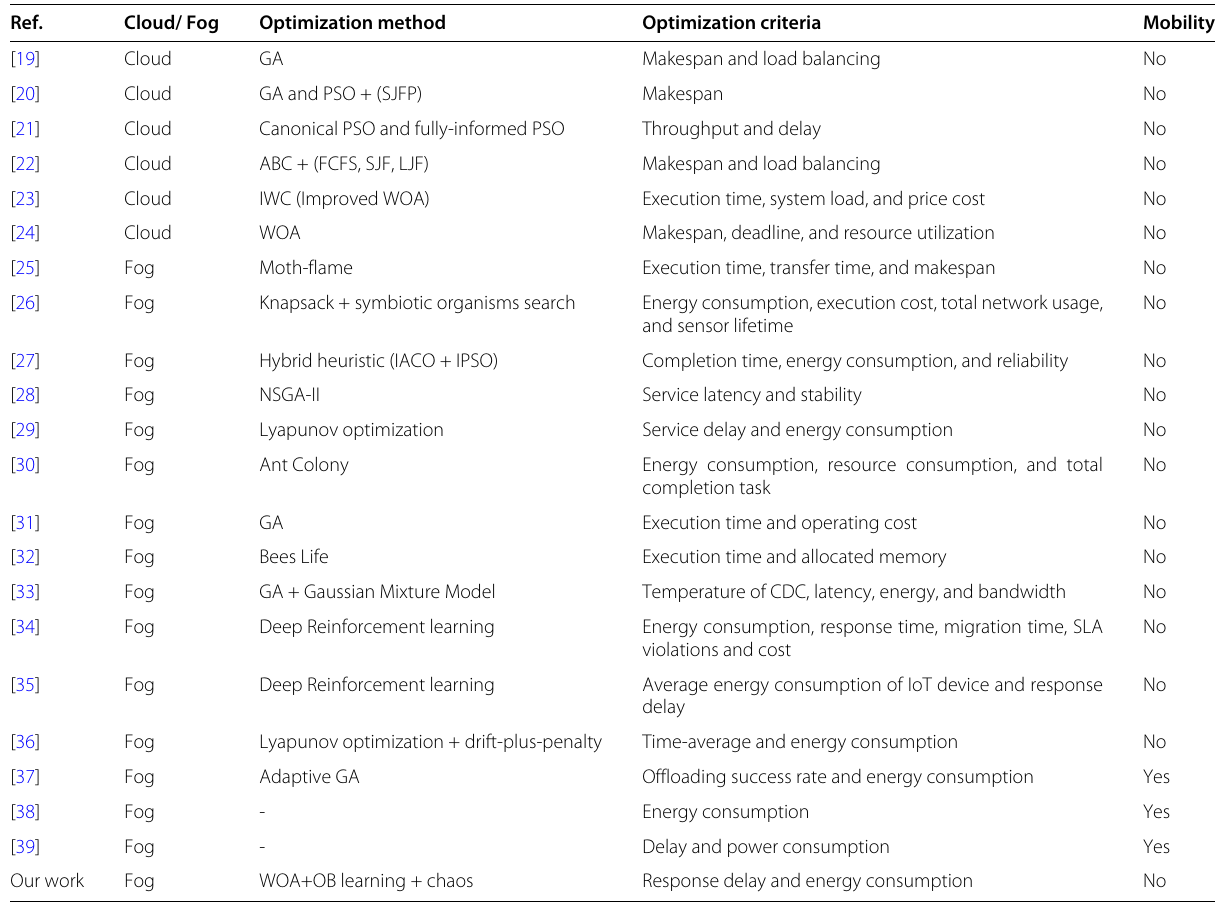
Table 1 Task scheduling in fog and cloud computing